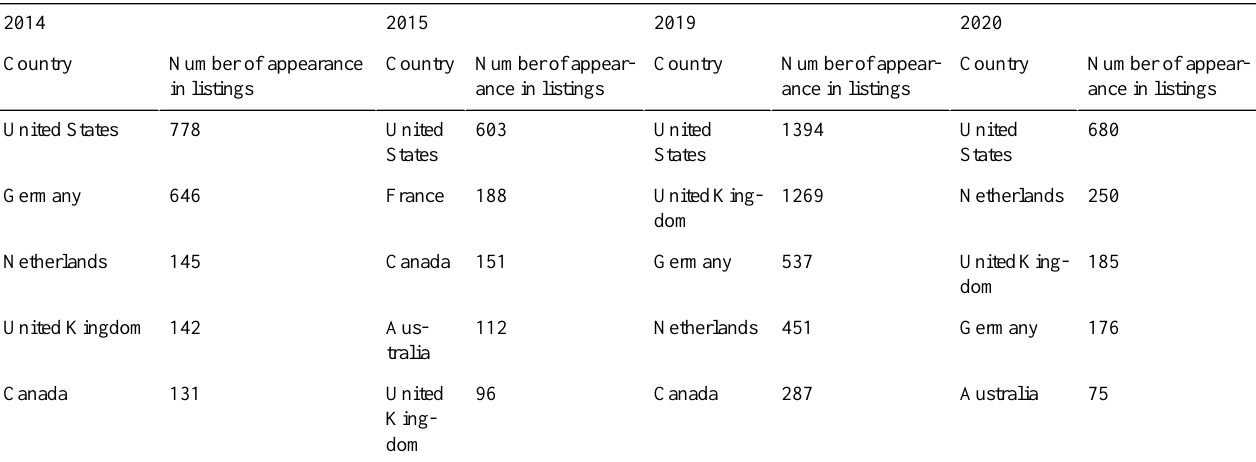
Table 8. Top 5 advertised origin countries according to different years. Note that data for 2020 only included data from January to